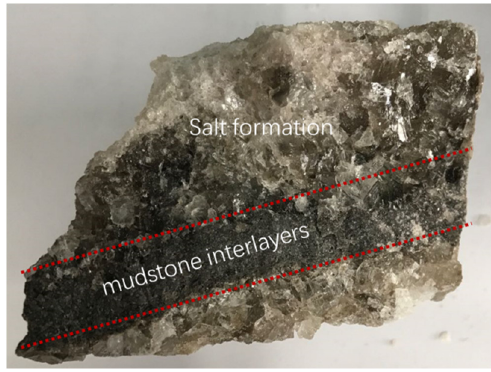
Figure 3. Multi-interlayer salt rock derived from well A. Table 1. Mineral composition analysis of insoluble sediments in well A.